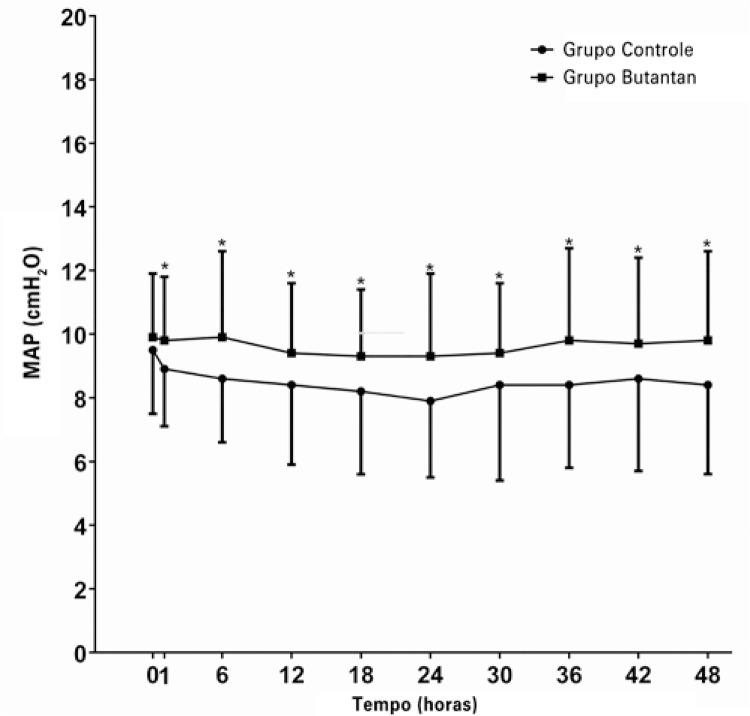
Valores da pressão média de vias aéreas, antes e após o tratamento, em ambos grupos de estudo